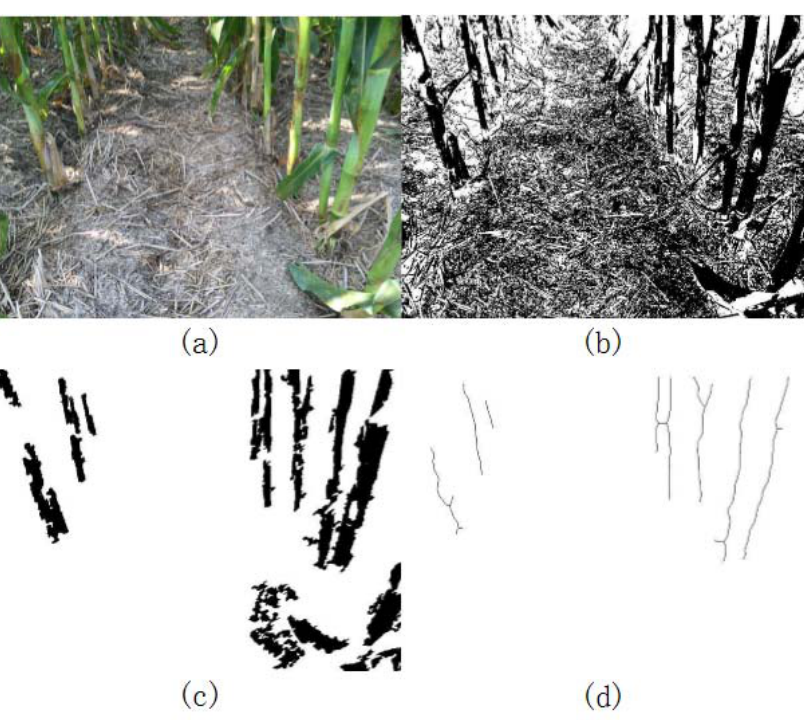
Figure 7. ( a ) The original image; ( b ) the results of Otsu threshold analysis; ( c ) the results of a block filter; and ( d ) the results of extracting the ridge line.